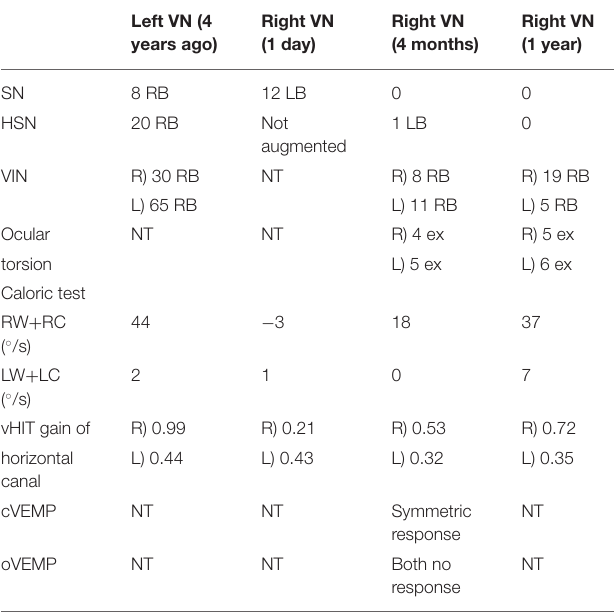
TABLE 2 | A summary of changes of vestibular function in Case 2. Left VN (4 years